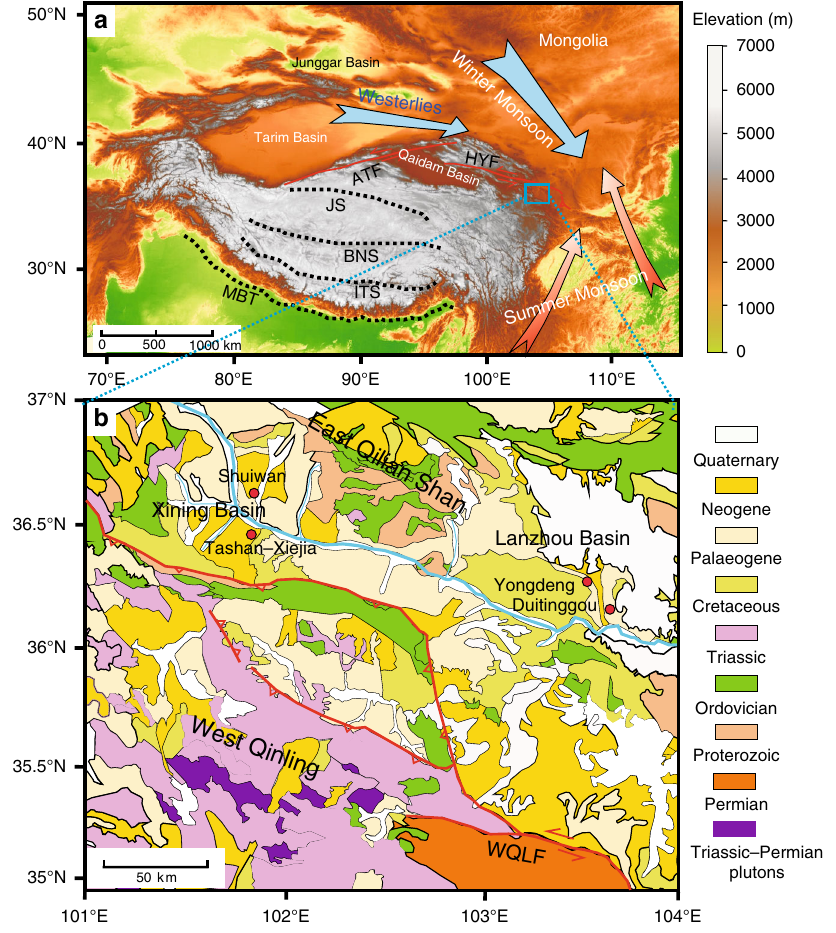
Fig. 1 Site location. a Topographic map of the present-day Tibetan Plateau region with relevant atmospheric features (indicated with blue and brown arrows) and major tectonic features (MBT, Main Boundary Thrust of the Himalaya; ITS, Indus-Tsangpo Suture; BNS, Bangong-Nujiang Suture; JS: Jinsha Suture; ATF, Altyn Tagh Fault; HYF, Haiyuan Fault). b Simpli fi ed geological map of the Lanzhou and Xining basins with the West Qinling Fault (WQLF) and locations of sections (red solid circles) mentioned in the